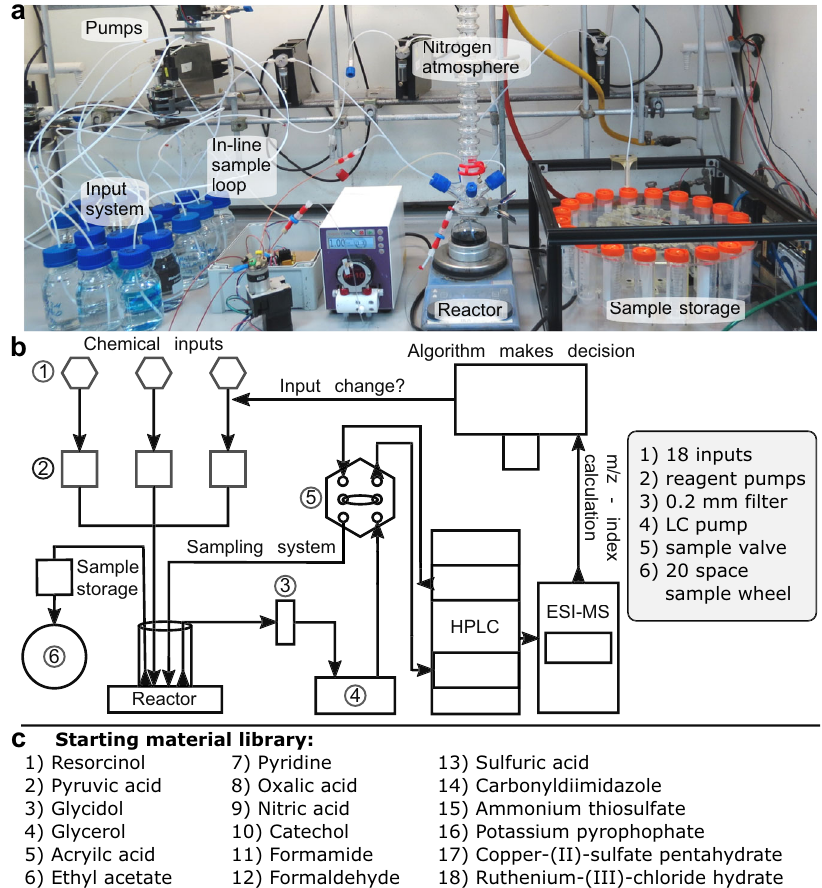
Fig. 2 Platform overview. a A photograph of the platform set up is shown above. The analytical system, including HPLC – MS and the computer, which controlled the platform processes, is not shown in the photograph. b A detailed schematic depiction is shown in the middle. c A list of the starting material library is shown